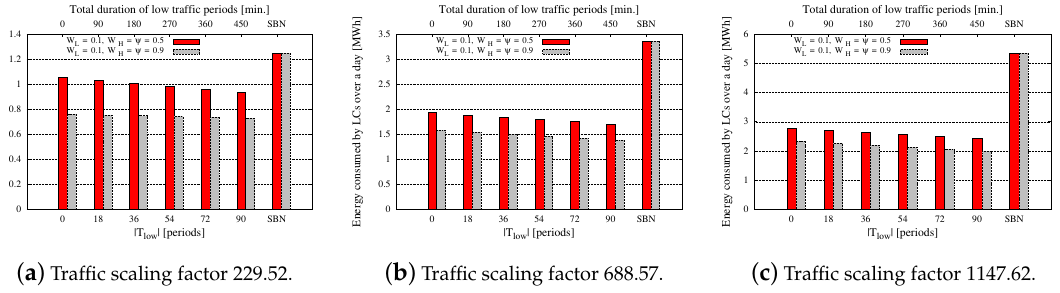
( a ) Traffic scaling factor 229.52. ( b ) Traffic scaling factor 688.57. Figure 5. Energy consumption E EWA over a day vs. the length of T low total